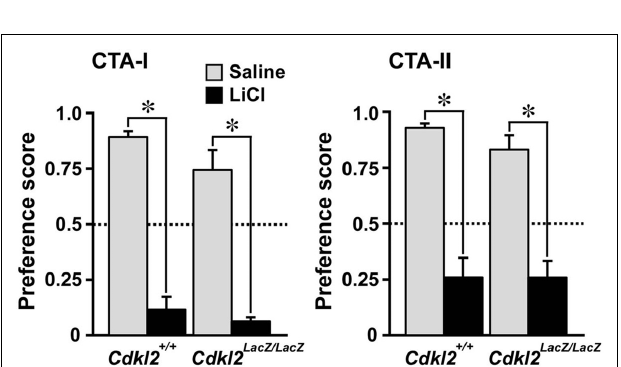
FIGURE 7 | Rotating-rod test. (A) Mice were trained once a day for fi ve consecutive days. Maximal time allowed on the rotating-rod was 300 s. (B) Mice were repeatedly trained for 1 day until they stayed on the rod longer than 60